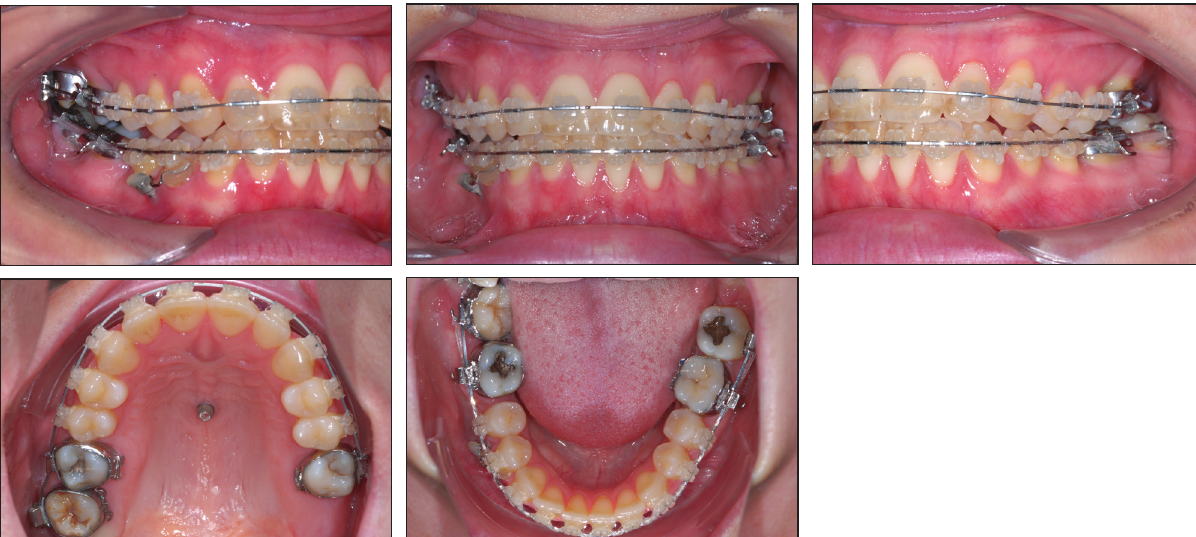
Figure 8. Mid-treatment intra-oral photographs (after completion of maxillary space closure and removal of Mesialslider and one palatal mini-screw).